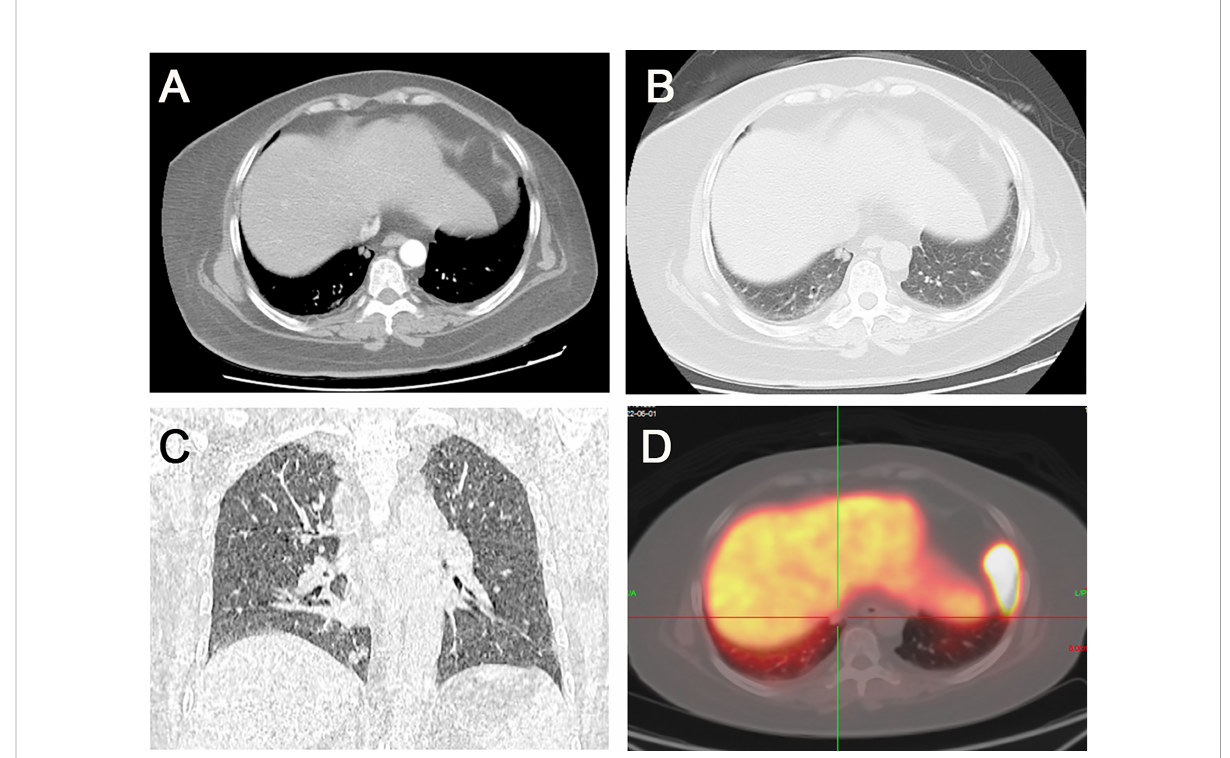
FIGURE 1 (A) Two rounded nodules in the right lower lobe of the lung, with well-de fi ned borders and a diameter of about 6 mm. (B) Signi fi cant enhancement of the nodules in the arterial phase. (C) Coronal image showing the location of the nodules near the heart and diaphragm. (D) 68 Ga- DOTATATE PET-CT did not show signi fi cant drug uptake.